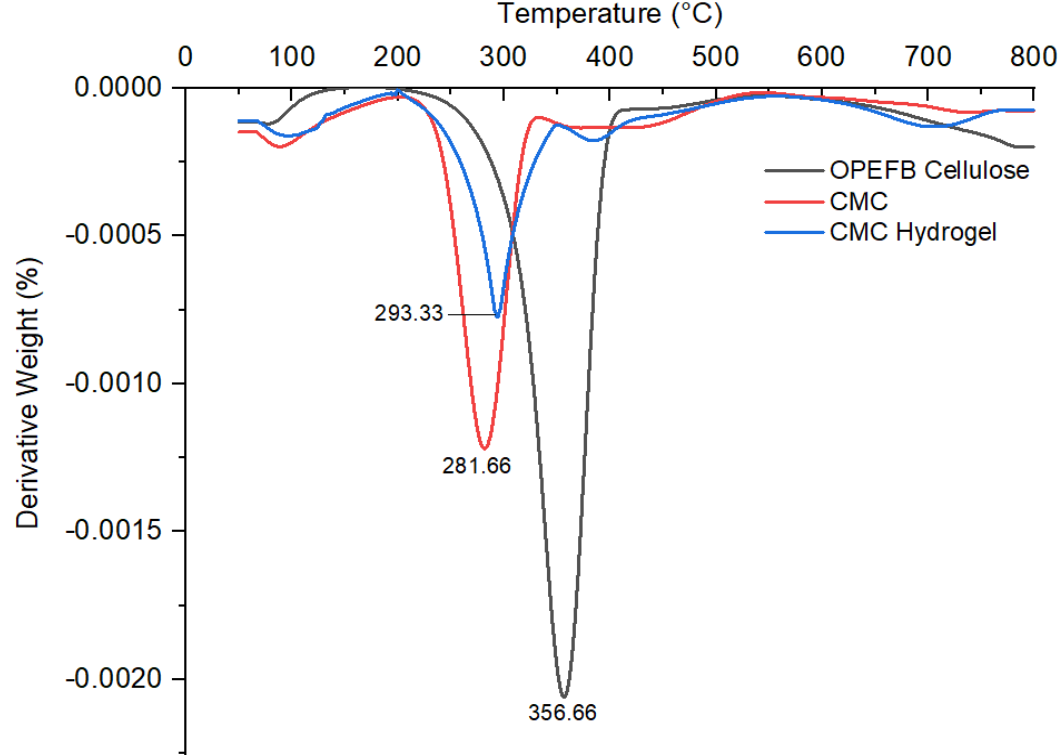
Figure 11. DTG thermograms of OPEFB cellulose, CMC, and CMC